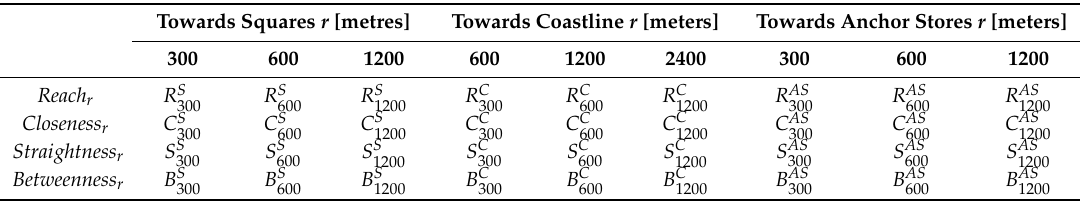
Table A3. Summary table of the 36 directional centrality indicators. r , radius; S , squares; C , coastline, AS , anchor stores.